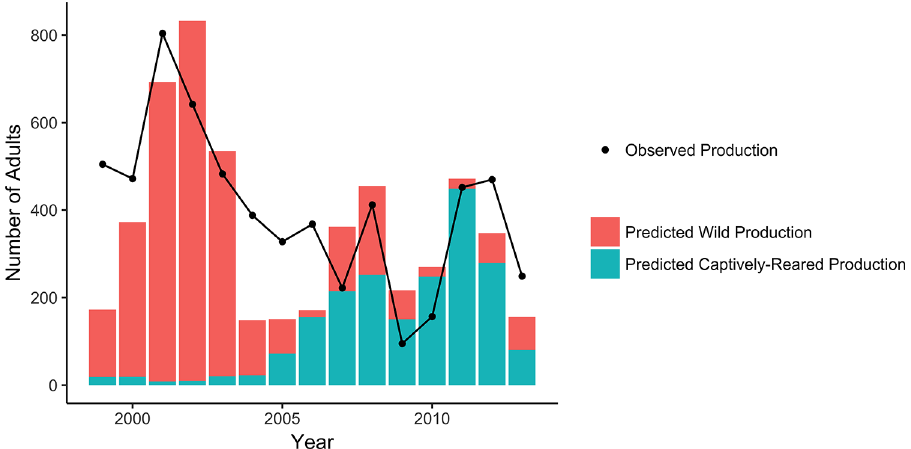
Fig 6. Adult abundances predicted by the size-conditional model. Shownare predictionswith apparent transition rates q 3 and q 4 .